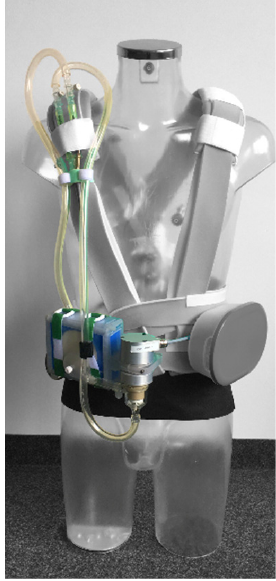
Figure 2. Prototype system of portable VV-ECMO system.